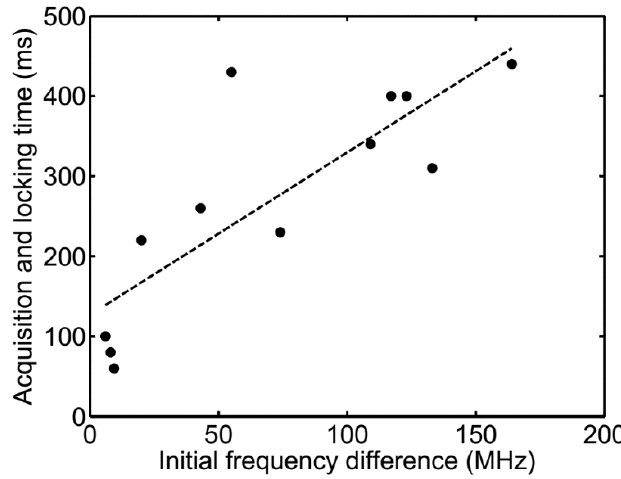
Figure 6. Measured frequency acquisition and phase locking time vs. the initial frequency difference. The dashed line is the linear fitting line.